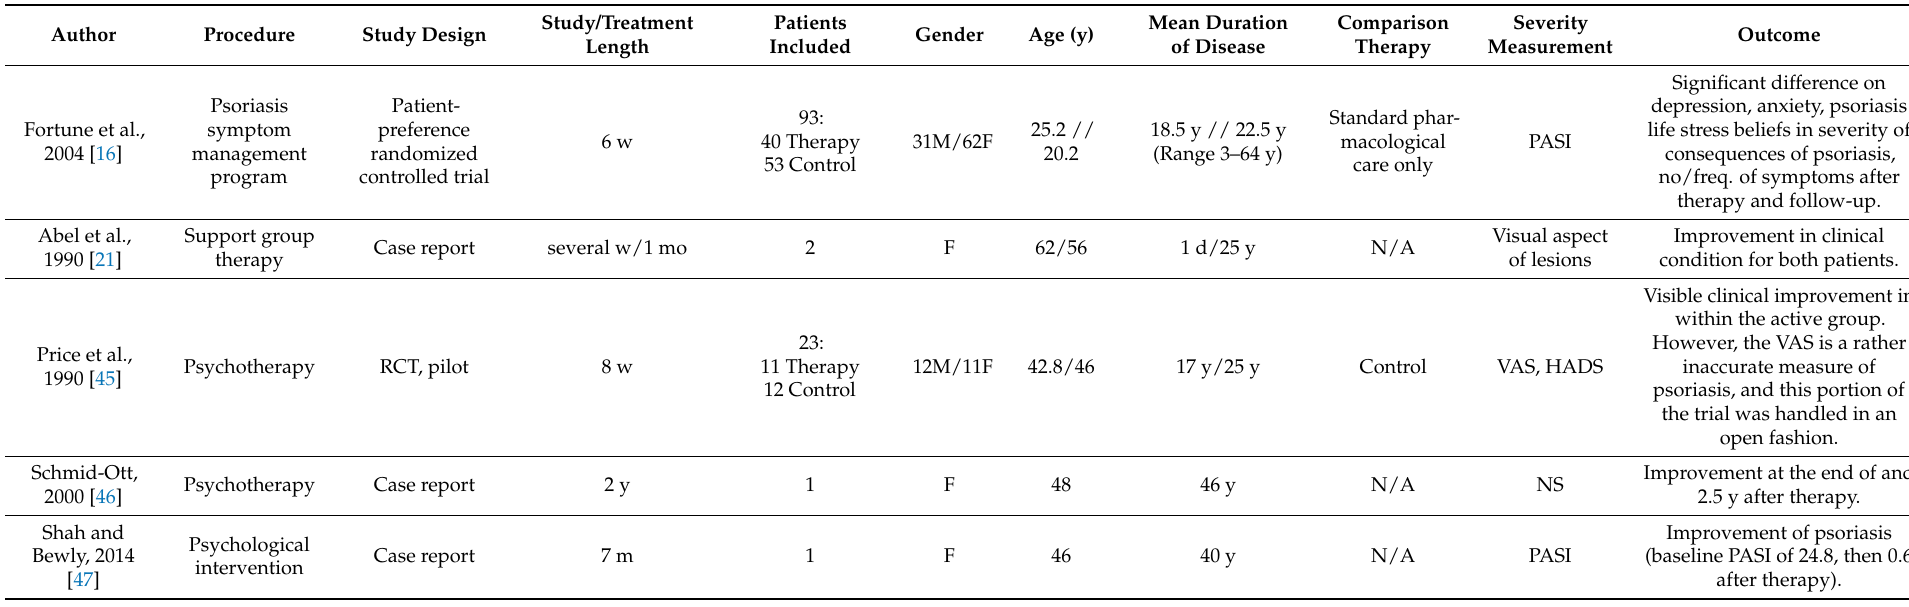
Table 3. Trials and case reports of patients following psychotherapy, stress management, hypnosis, and meditation for psoriasis (arranged in order of